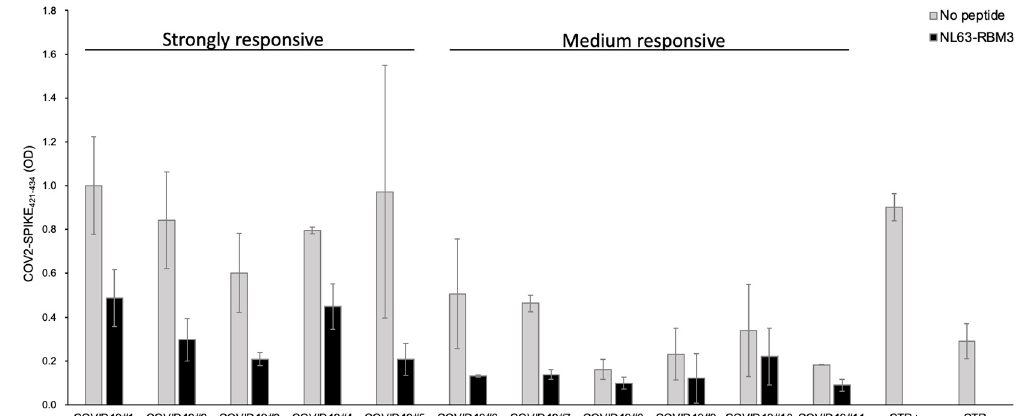
Figure 6. Competition assay with COV2-SPIKE 421–434 coated ELISA plate. Plasma from 11 COVID19 patients, with strong and medium antibody response against COV2-SPIKE 421–434 epitope, were pre-incubated overnight with NL63-RBM3. The grey and black bars represent plasma reactivity against COV2-SPIKE 421–434 under normal conditions and after incubation with NL63-RBM3, respectively. Positive and negative controls were included in the assay.